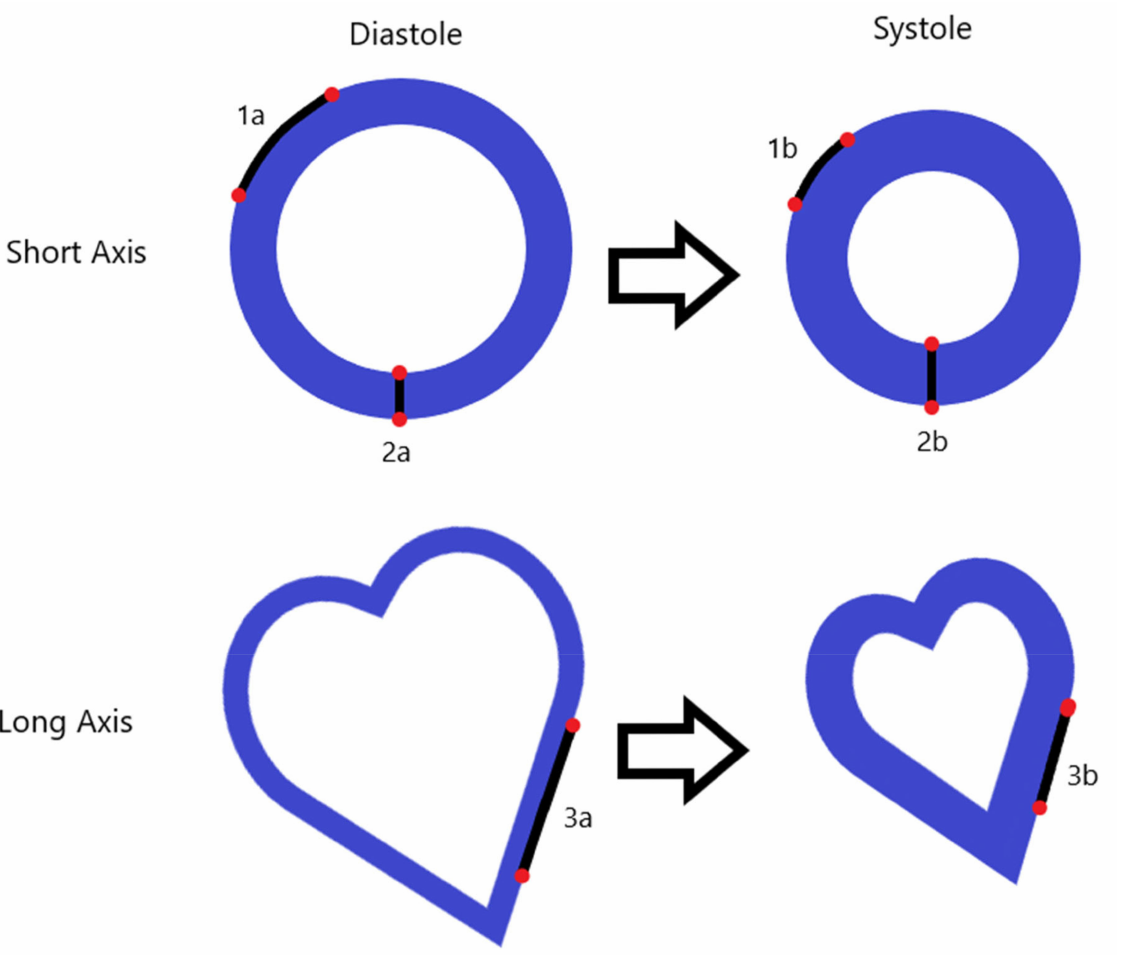
Figure 3. A graphical representation of the principal strain directions. The black lines represent the distance between two hypothetical features (the red dots). 1a and 1b demonstrate circumferential shortening, 2a and 2b demonstrate radial thickening, and 3a and 3b demonstrate longitudinal shortening. Rahman et al. published an extensive systematic review article in which they found a reasonable to decent agreement for feature tracking when compared to 2D echo-based speckle tracking (9.5% and 16.4% inter-modality variation for global circumferential strain and global longitudinal strain, respectively) [42]. Feature tracking can be applied using the same